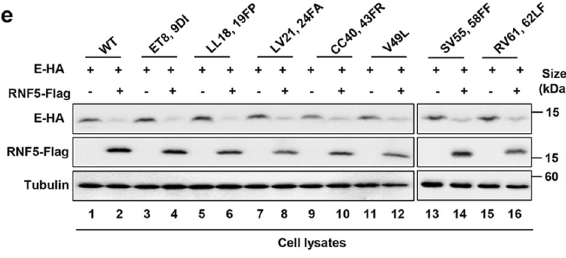
Fig. 6e All tested E alleles from different SARS-CoV-2 variants were sensitive to